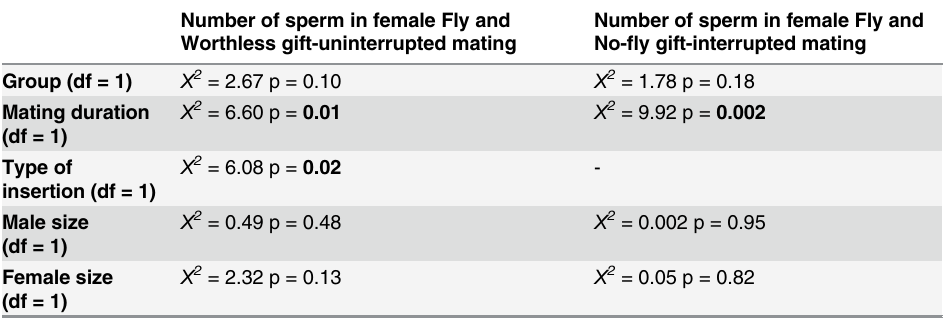
Table 1. Effects on the number of sperm stored by females in Fly gift-uninterrupted mating, Worthless gift-uninterrupted mating, Fly gift-interrupted mating, No-fly gift-uninterrupted mating groups. Number of sperm in female Fly and Number of sperm in female Fly and Worthless gift-uninterrupted mating No- fl y gift-interrupted mating Group (df = 1) Χ 2 = 2.67 p = 0.10 Χ 2 = 1.78 p =